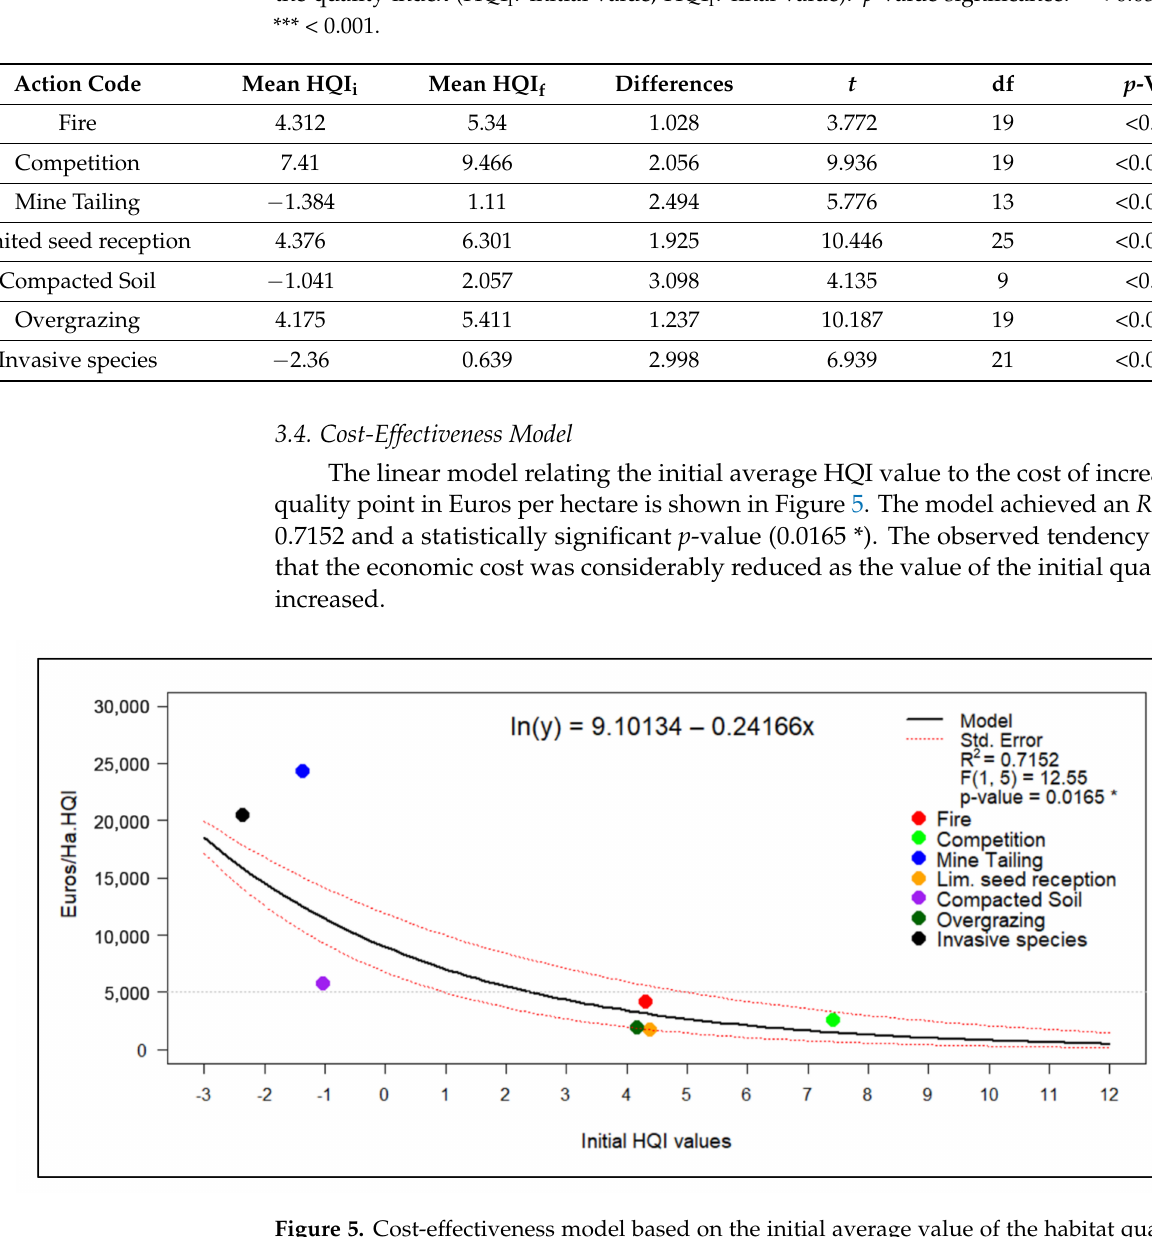
Figure 5. Cost-effectiveness model based on the initial average value of the habitat quality index. p -value significance: * < 0.05, ** < 0.01, *** <